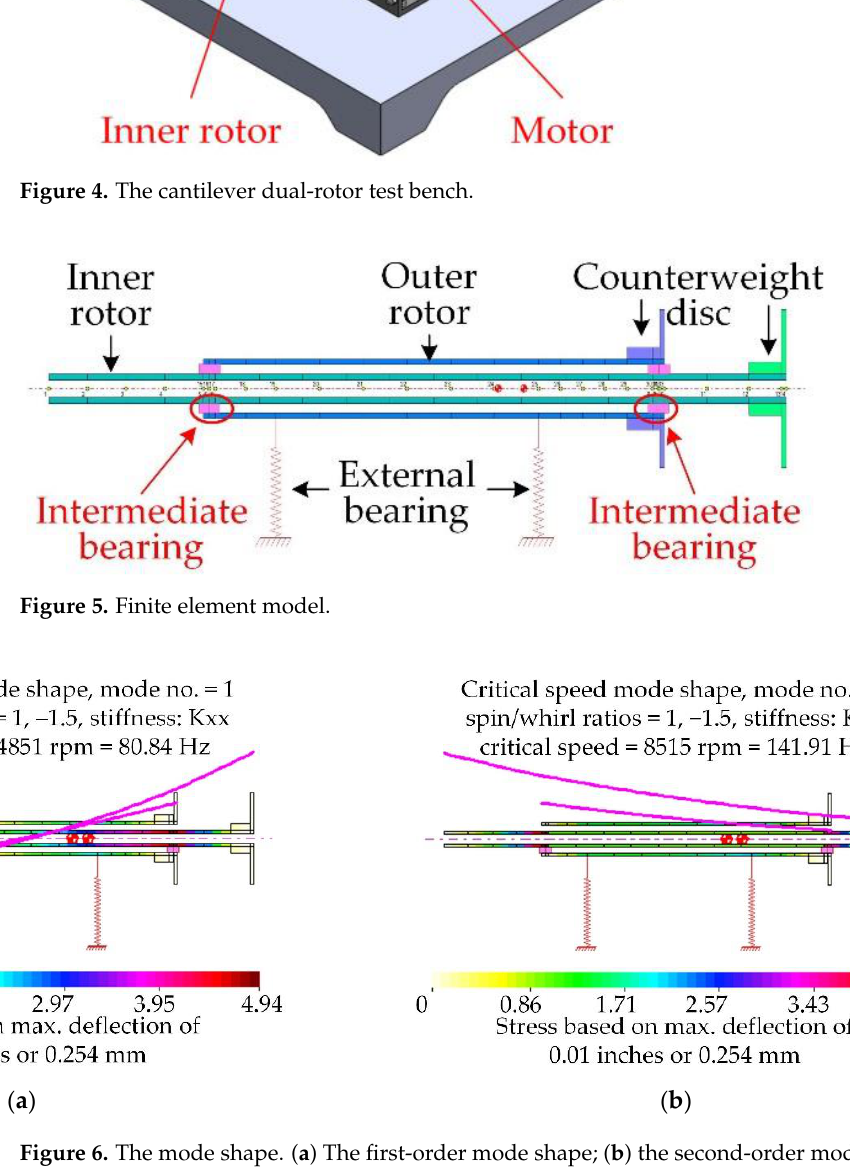
Figure 4. The cantilever dual-rotor test bench.